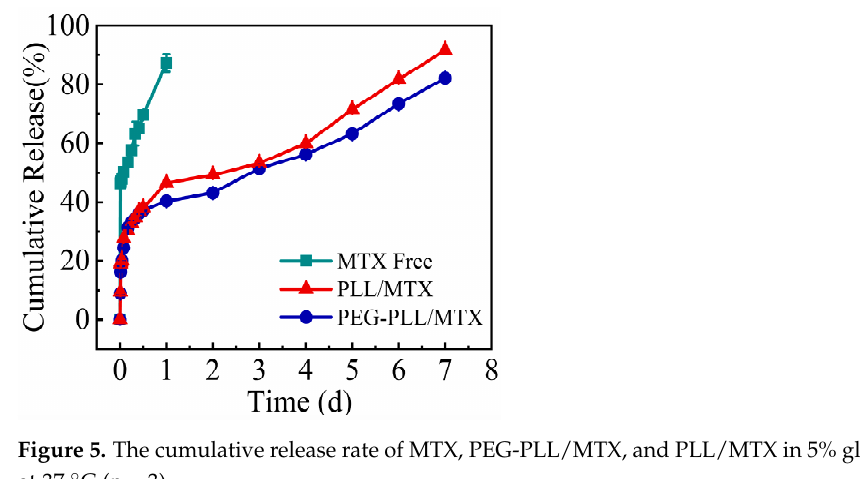
Figure 4. Study on the Storage stability of PLL/MTX NPs ( a ) and PEG-PLL NPs ( b ) (4 °C, 14 d); media stability of the two NPs in 5% glucose solution ( c ) and plasma ( d ) (n = 3).